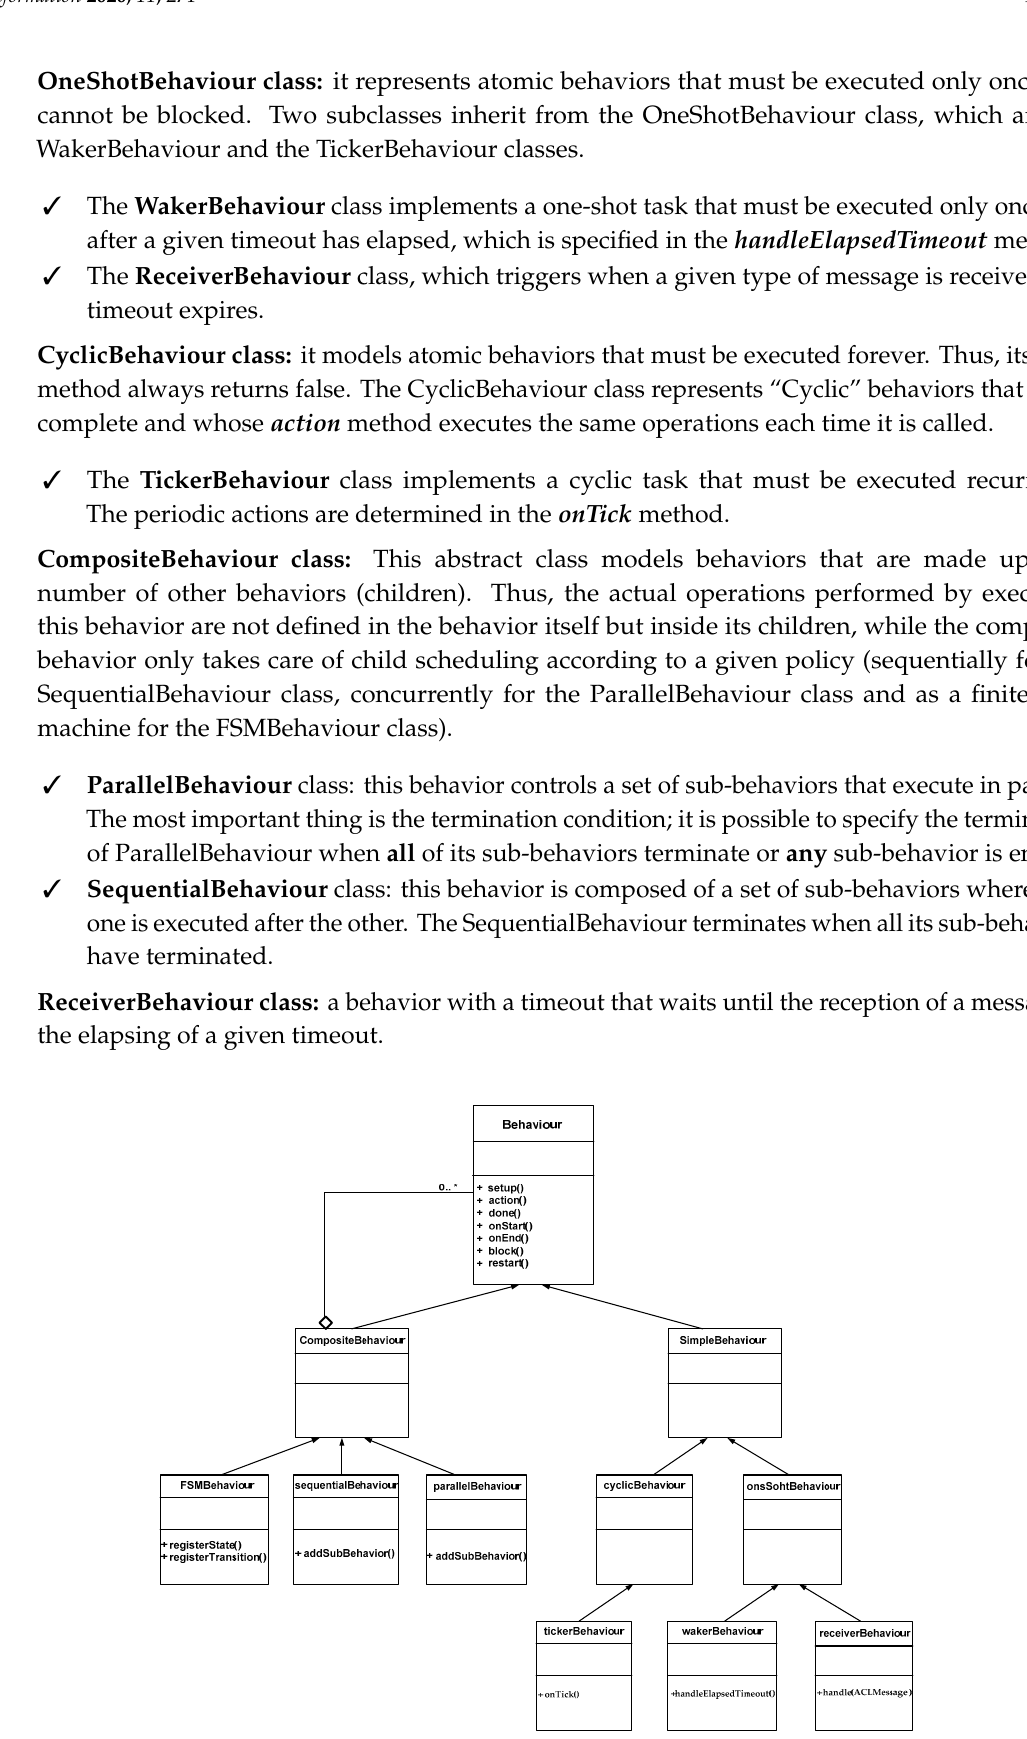
Figure 4. Behavior class hierarchy in JADE.